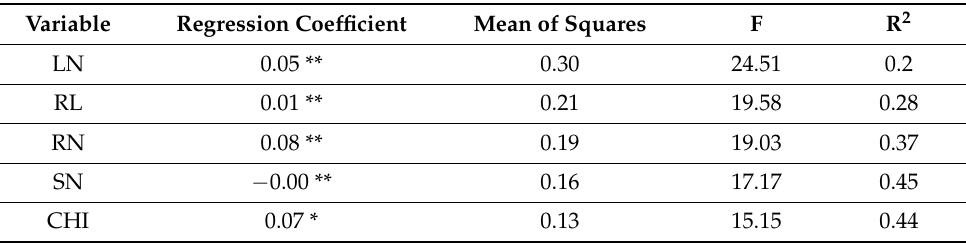
Table 5. Forward regression under normal conditions when plant weight was considered as a dependent variable and the other attributes as independent variables. Variable